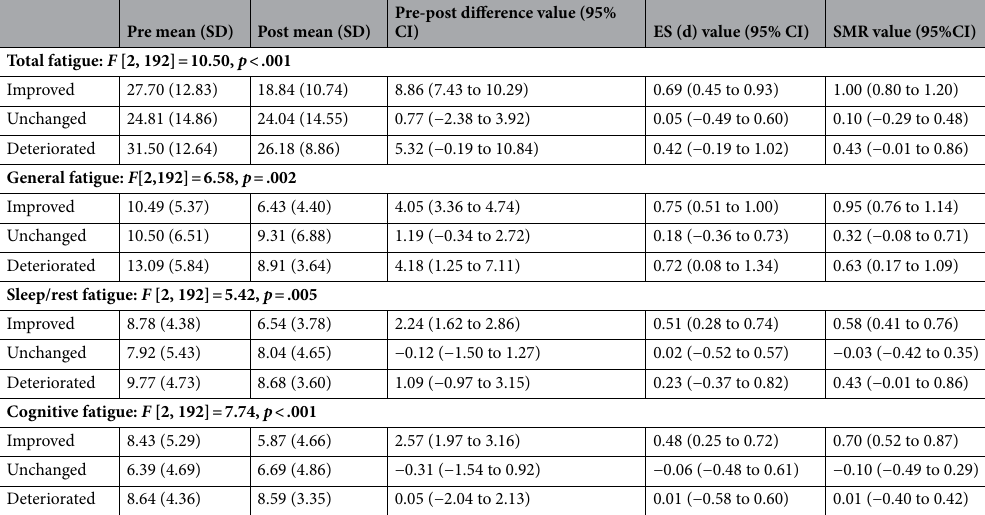
Table 3. Mean differences in PedsQL-MFS scores according to FSS change category.